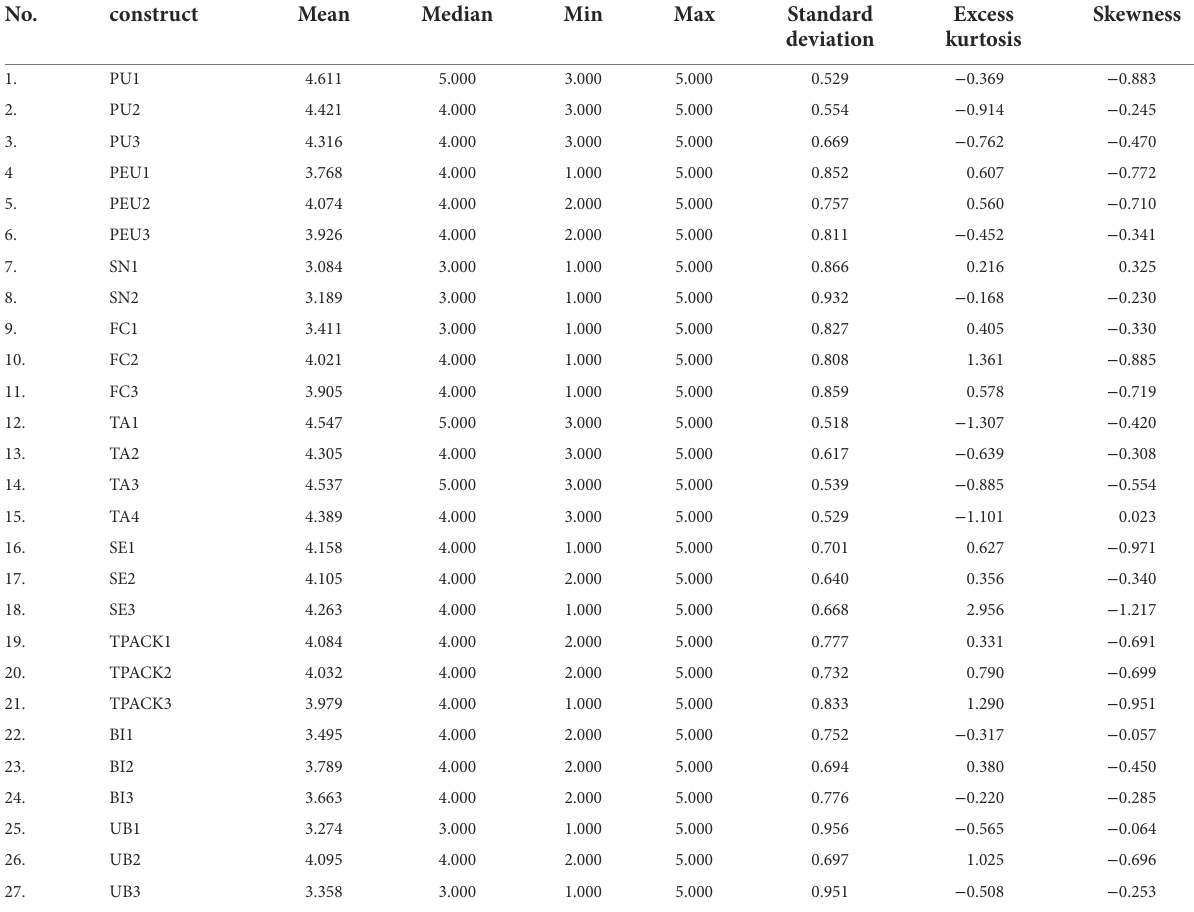
TABLE 2 Descriptive statistics and normality